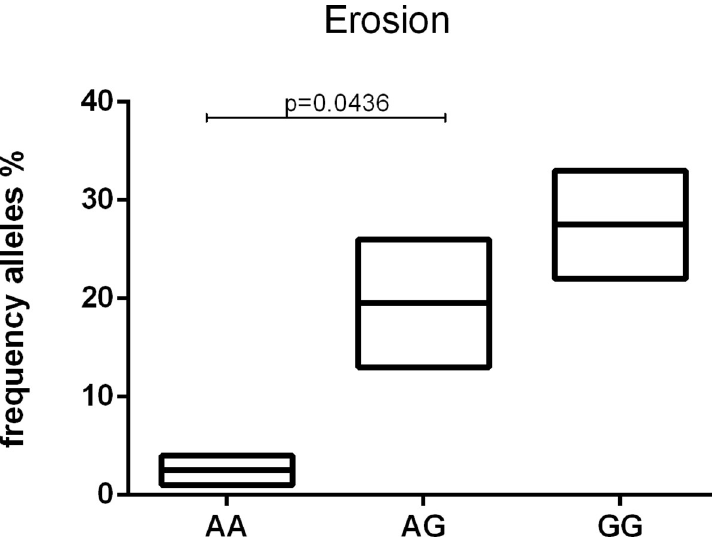
Fig 2. Erosion stratified by genotypes of LGALS9 gene polymorphisms (rs3763959) in RA patients.